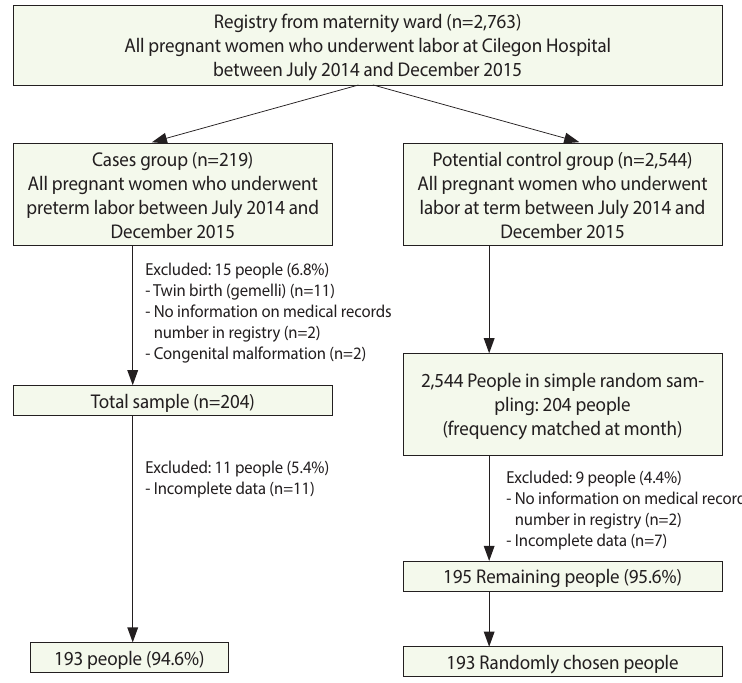
Figure 1. Sampling